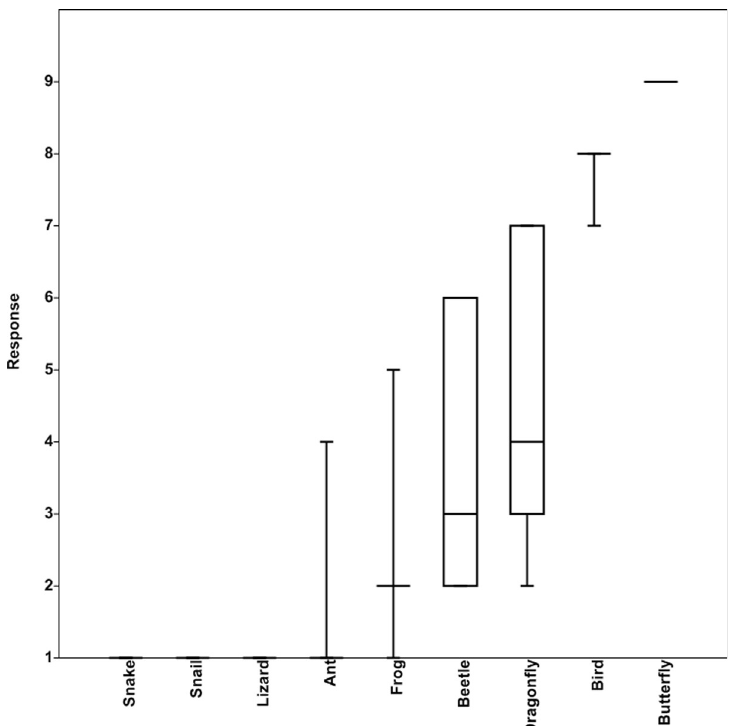
Fig 2. Likert-scale fondness survey across nine commonly found taxa within neighbourhood parks using box and whisker plot.